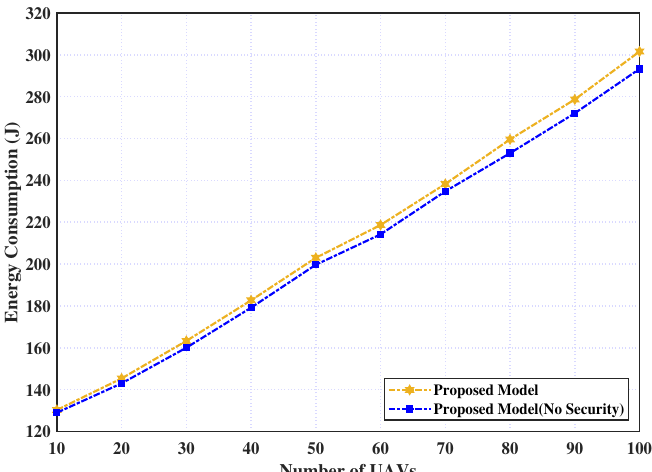
Figure 4. Proposed model with and without the security layer over number of